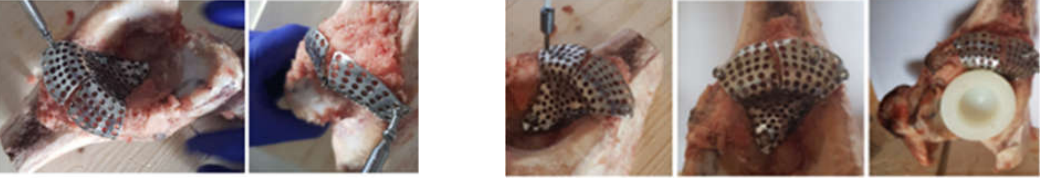
Figure 12. Fixing the reconstructive mesh with orthopaedic screws.